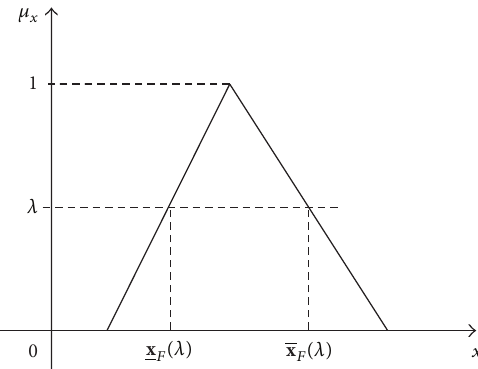
Figure 1: The membership function showing an 𝜆 -cut.